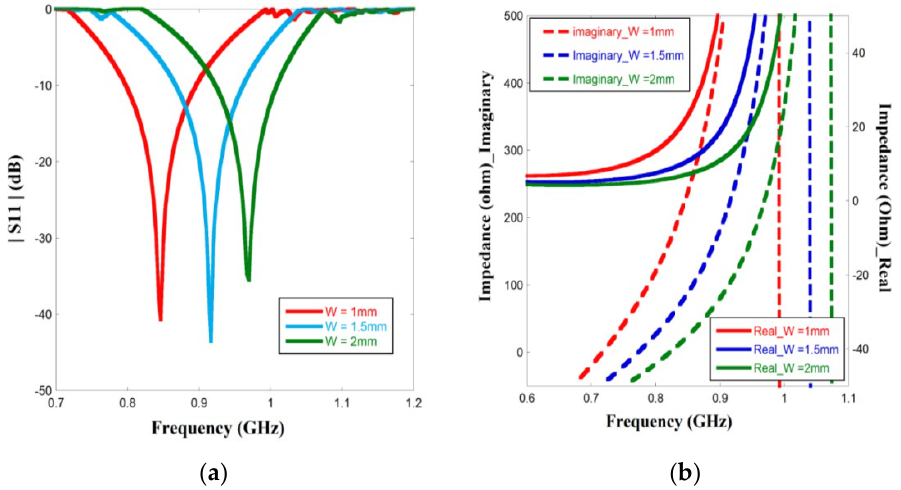
Figure 6. Parametric study of simulated ( a ) | S 11| and ( b ) complex impedance for different W .